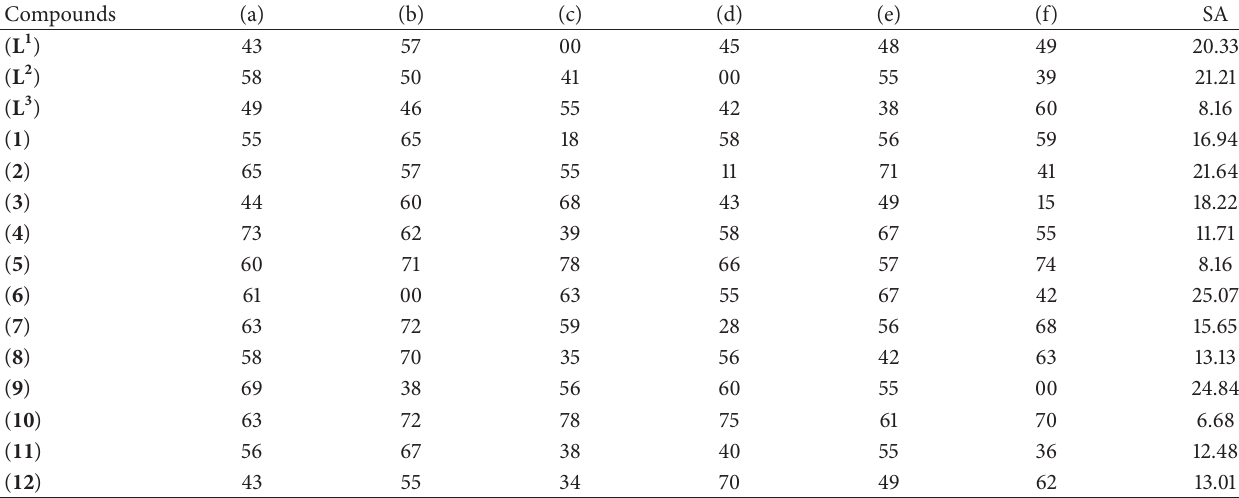
Table 2: Antifungal bioassay of ligands and their metal(II) complexes (% inhibition).